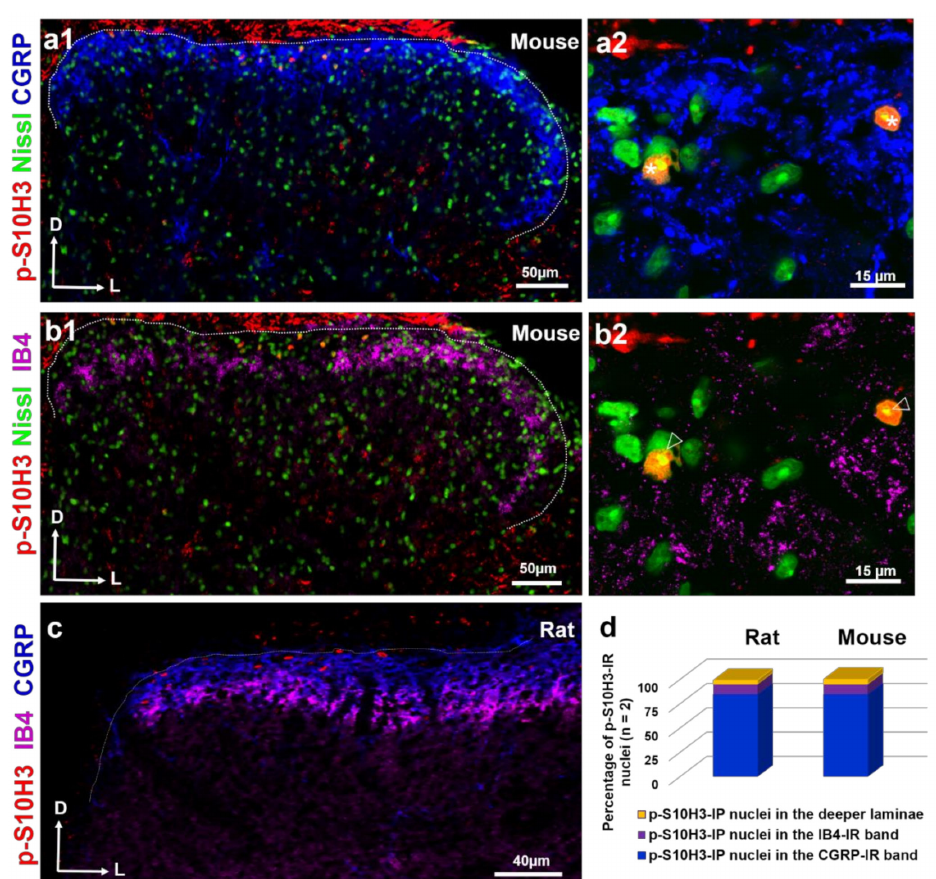
Figure 2. Neurons in the superficial dorsal horn exhibiting p-S10H3 immunoreactivity after burn injury show close appositions with CGRP-containing peptidergic afferents. ( a1 , a2 ) Immunostaining with antibodies against p-S10H3 (red), CGRP (blue) and Nissl (green). ( a2 ) Asterisks indicate p-S10H3-positive neurons presenting close appositions with CGRP- containing peptidergic terminals. ( b1 , b2 ) Immunostaining with antibodies against p-S10H3 (red), isolectin B4 (IB4) (purple) and Nissl (green). ( b2 ) None of the three p-S10H3-immunopositive neurons (empty arrowheads) have IB4 terminals in their vicinity. ( c ) Immunostaining with antibodies against p-S10H3 (red), CGRP (blue) and IB4 (purple). Dotted lines indicate the border between gray and white matter. D, dorsal; L, lateral. ( d ) Distribution of p-S10H3-immunoreactive nuclei within the CGRP- and IB4-positive bands and also in the deeper laminae of the SDH of rats and mice (n = 2 animals per species). The CGRP band contains the vast majority of p-S10H3 nuclei in both